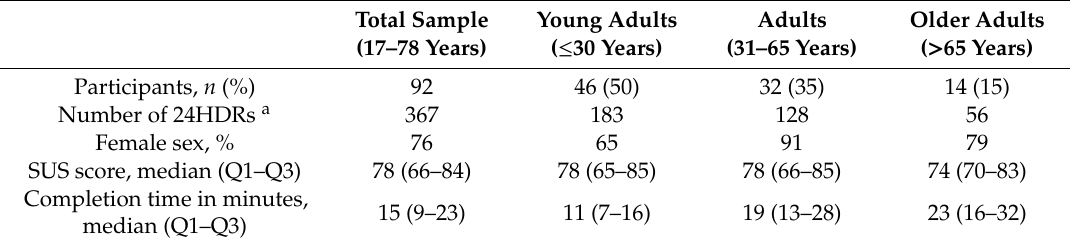
Table 2. System usability scale (SUS) scores and calculated completion time for a 24HDR with myfood24-Germany stratified by age groups and for the total